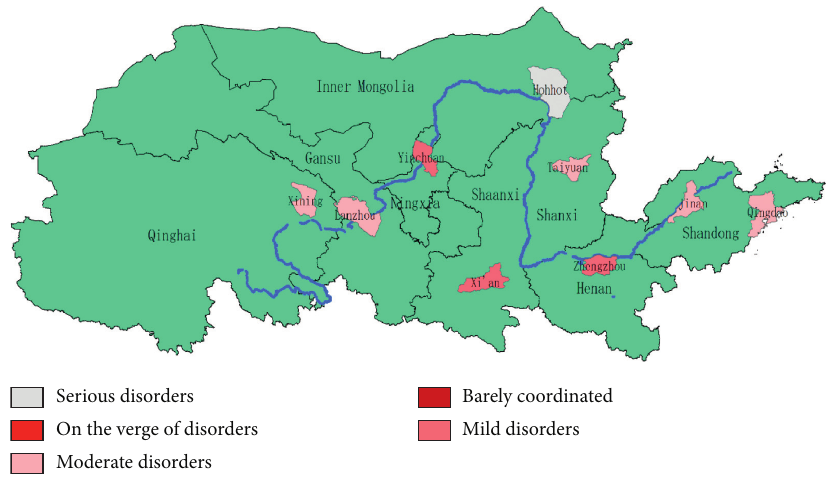
Figure 5: Coupling coordination level of central cities in the Yellow River Basin in 2010.